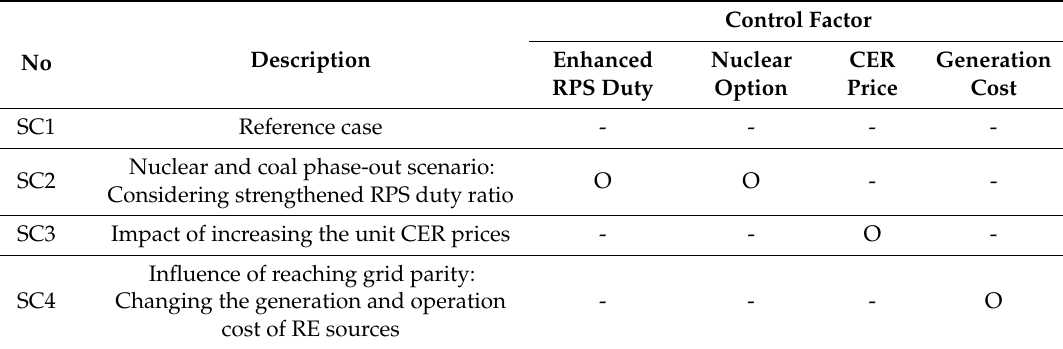
Table 2. Basic information for each